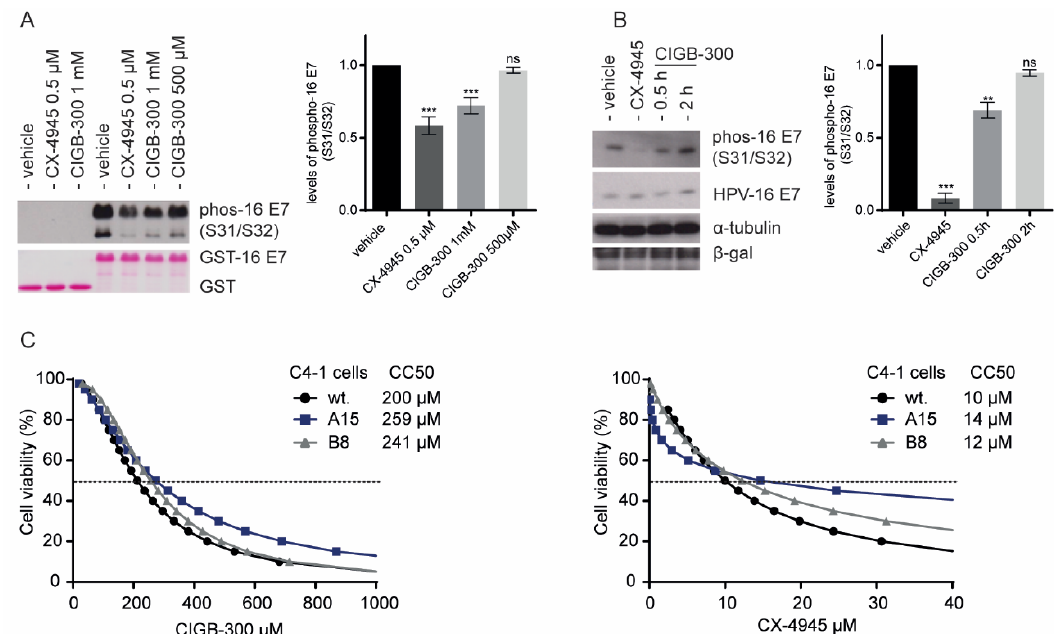
Figure 3. Impact of targeting HPV-16 E7 CK2-mediated phosphorylation on the cytotoxic effect of CIGB-300. ( A ). In vitro phosphorylation assay, using purified GST-HPV-16 E7 fusion proteins incubated with the purified CK2 enzyme, in the presence of ATP and CK2 inhibitors. The samples were analyzed by western blot using an antibody specific for phosphorylated HPV-16 E7 (S31/S32) (top panel). The bottom panel shows the Ponceau-stained membrane, indicating the total levels of GST-fusion E7 protein and GST control. ( B ). In vivo phosphorylation assay using E7-overexpressing HEK293 cells. The cells were treated with the CK2 inhibitor CIGB-300 (200 µ M) and CX-4945 (25 µ M) for 30 min and 2 h, respectively. The cells were then harvested directly in 2X sample buffer, resolved on 15%-SDS-PAGE and subjected to western blot analysis to identify phosphorylated E7 and total protein levels with the anti-HA antibody. β -gal was employed as a loading control. Relative densitometry analysis of p S31/32 HPV-16 E7 bands normalized to vehicle are indicated ( C ). Effect of CIGB-300 on the viability of wildtype and mutant C4-1 cells, using an XTT assay. The indicated cervical cancer cell lines were cultured for 48 h with increasing concentrations of CIGB-300 and CX-4945. CC 50 was estimated from the fitted dose–response curves based on treatment with five CK2 inhibitor concentrations, as determined by the cell viability assay. Results in ( A , B ) are shown as means ± SD from three independent experiments, while those in C are representative of three independent experiments (three replicates each). Statistically significant differences are represented as ** p < 0.01 and *** p < 0.001, determined using one-way ANOVA followed by Dunnett’s post-test; ns indicates